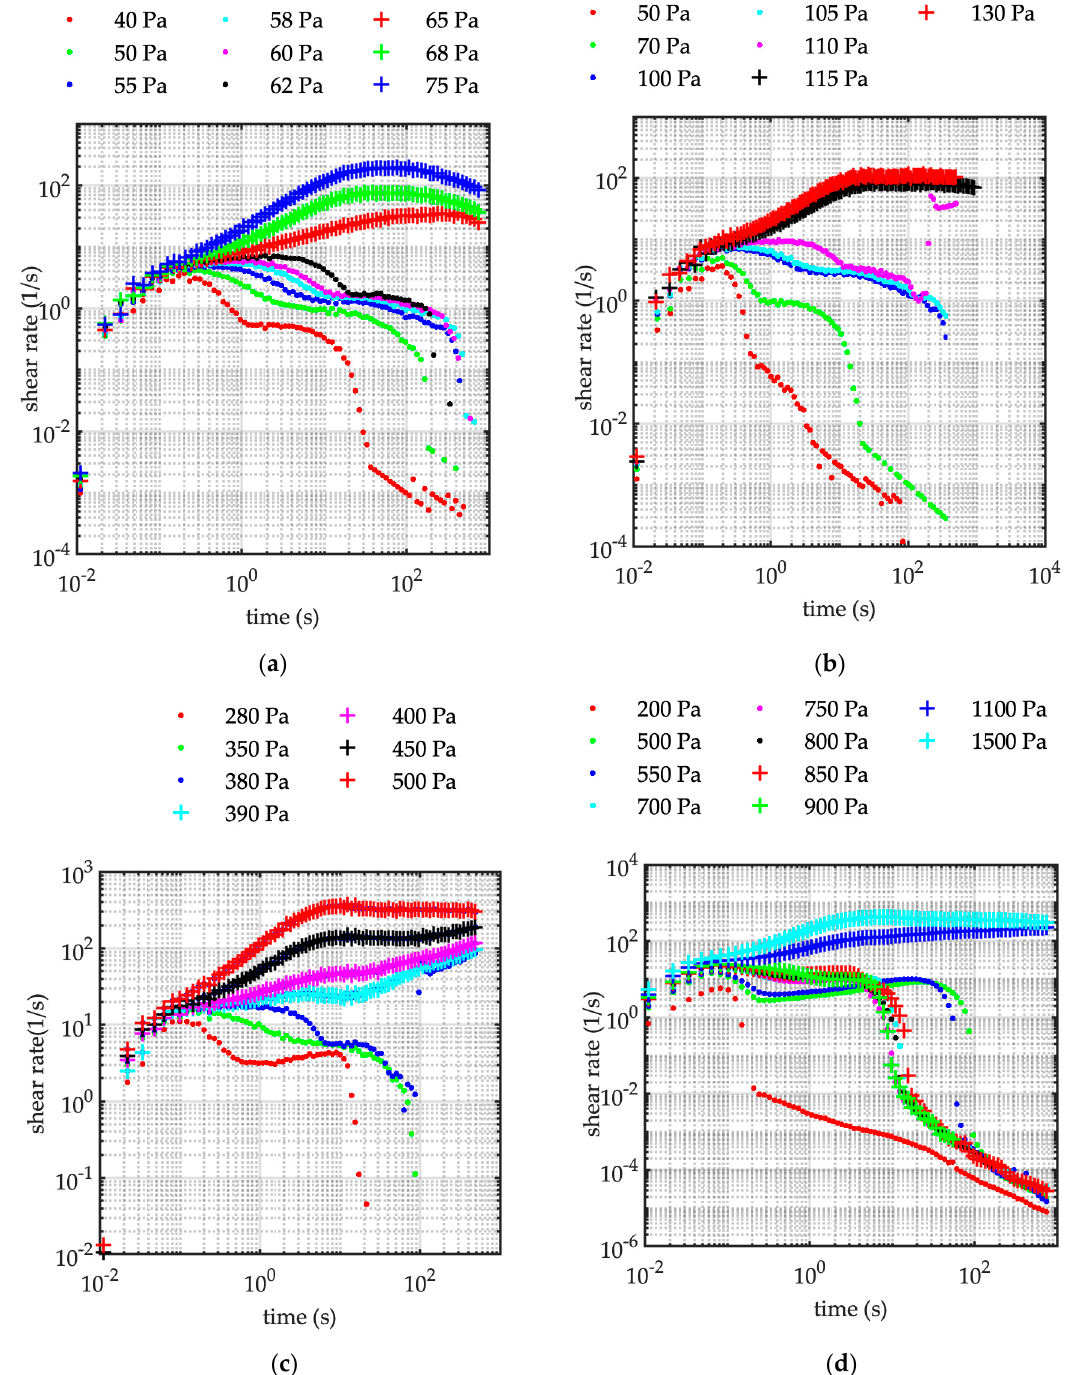
Figure 3. Creep test. The shear-time trend during the test. ( a ) Sediment concentration C = 50%. Runs C87–C95 (see Table 2) corresponding to the increasing applied shear as it is reported in the legend. ( b ) Sediment concentration C = 52%. Runs